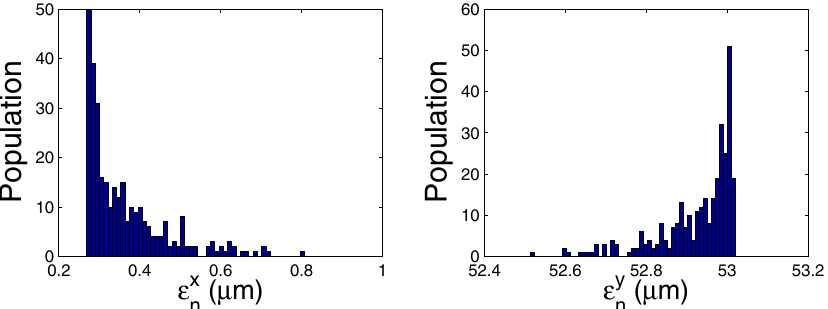
FIG. 6. (Color) Emittances variations due to nonoptimum quadrupole settings. The quadrupole settings were randomly varied from their nominal value by 2% (rms). Only simulations results corresponding to settings that provide a beam with an upright spot size at X7 and X8 were retained in the histograms (in order to mimic the experimental method used to tune the skew quadrupoles). The right and left plots correspond, respectively, to the horizontal and vertical flat-beam emittances.